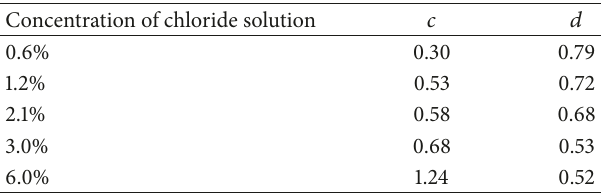
Table 4: The coefficients 𝑐 and 𝑑 for variable concentration of chloride solution in